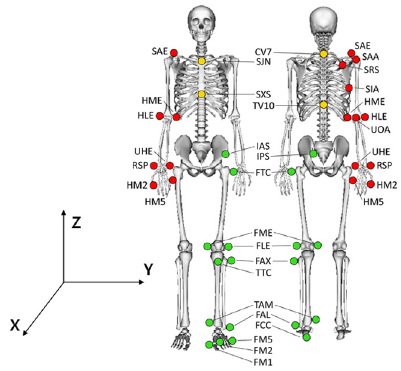
Figure 4 . Marker set for collecting human gait data [29].